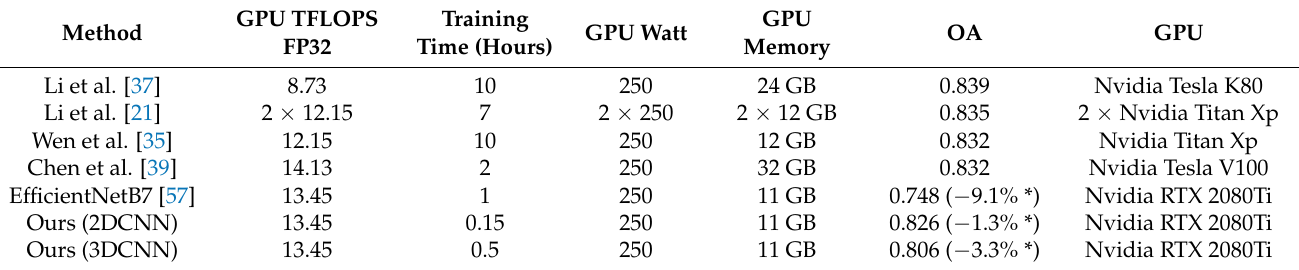
Table 12. Performance comparison between our methods and recent papers, ordered by OA. (* difference from the highest OA score in the table).